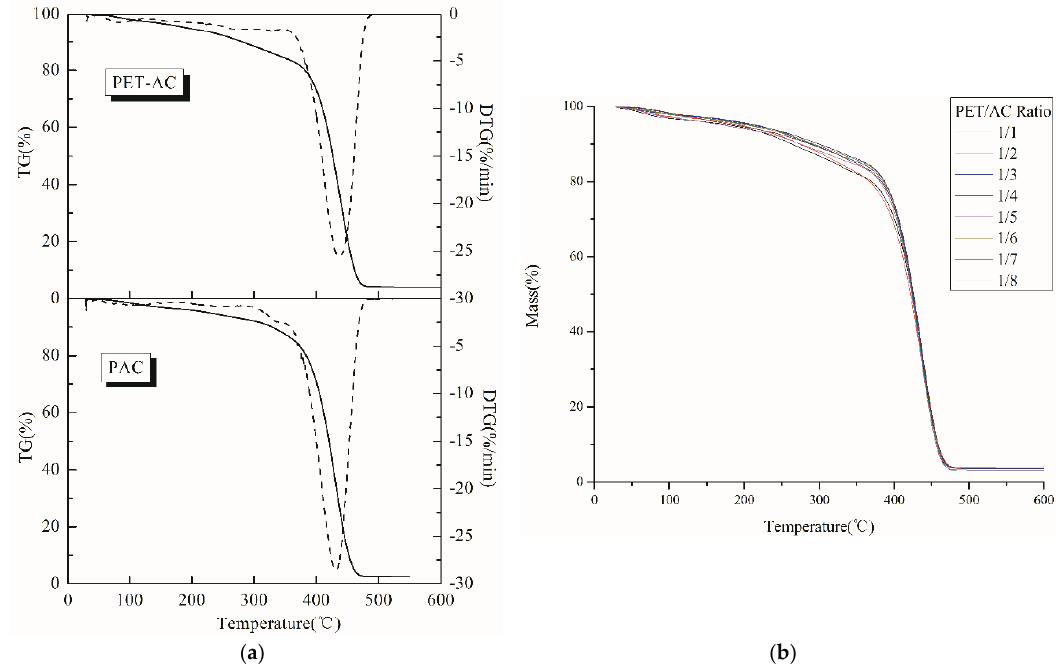
Figure 4. ( a ) TGA/DTGA curves of PET-AC and PAC; ( b ) . Thermogravimetric analysis of different Figure 4. ( a ) TGA / DTGA curves of PET-AC and PAC; ( b ) Thermogravimetric analysis of di ff erent ratios of PET/AC. ratios of PET / AC.